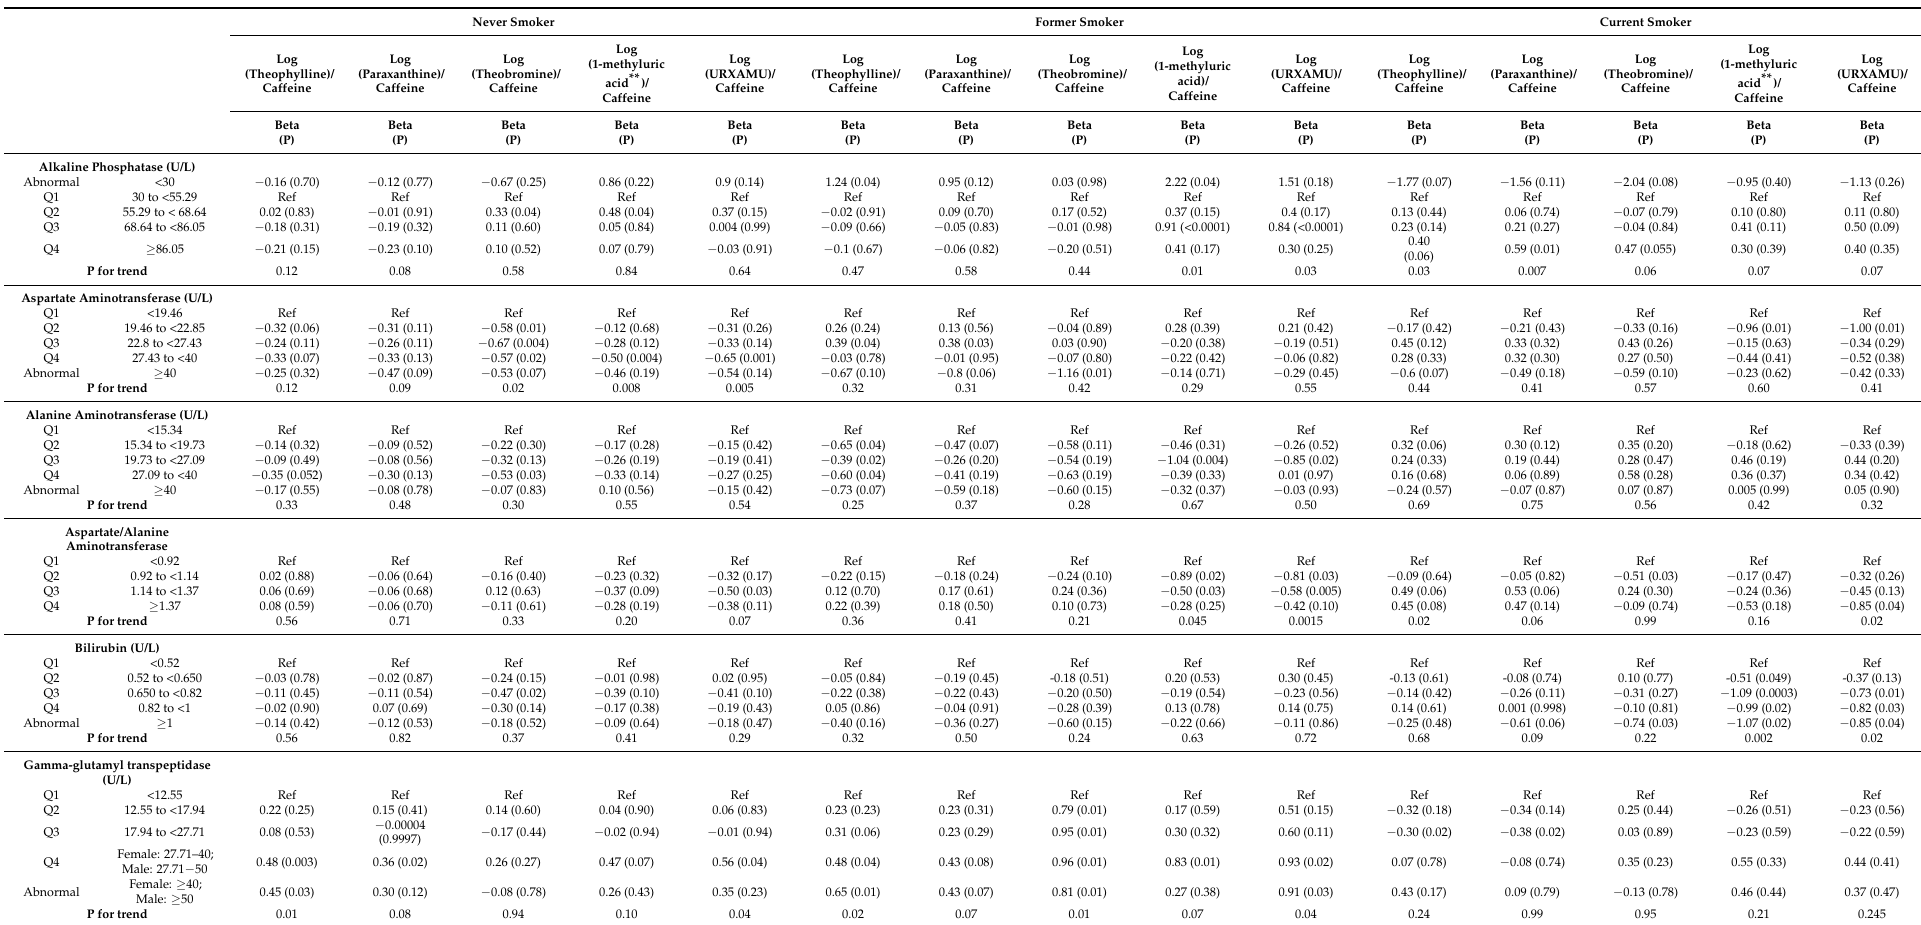
Table 2. Serum liver enzymes and caffeine metabolite indices (caffeine intake was calculated from the 24-h recall on day